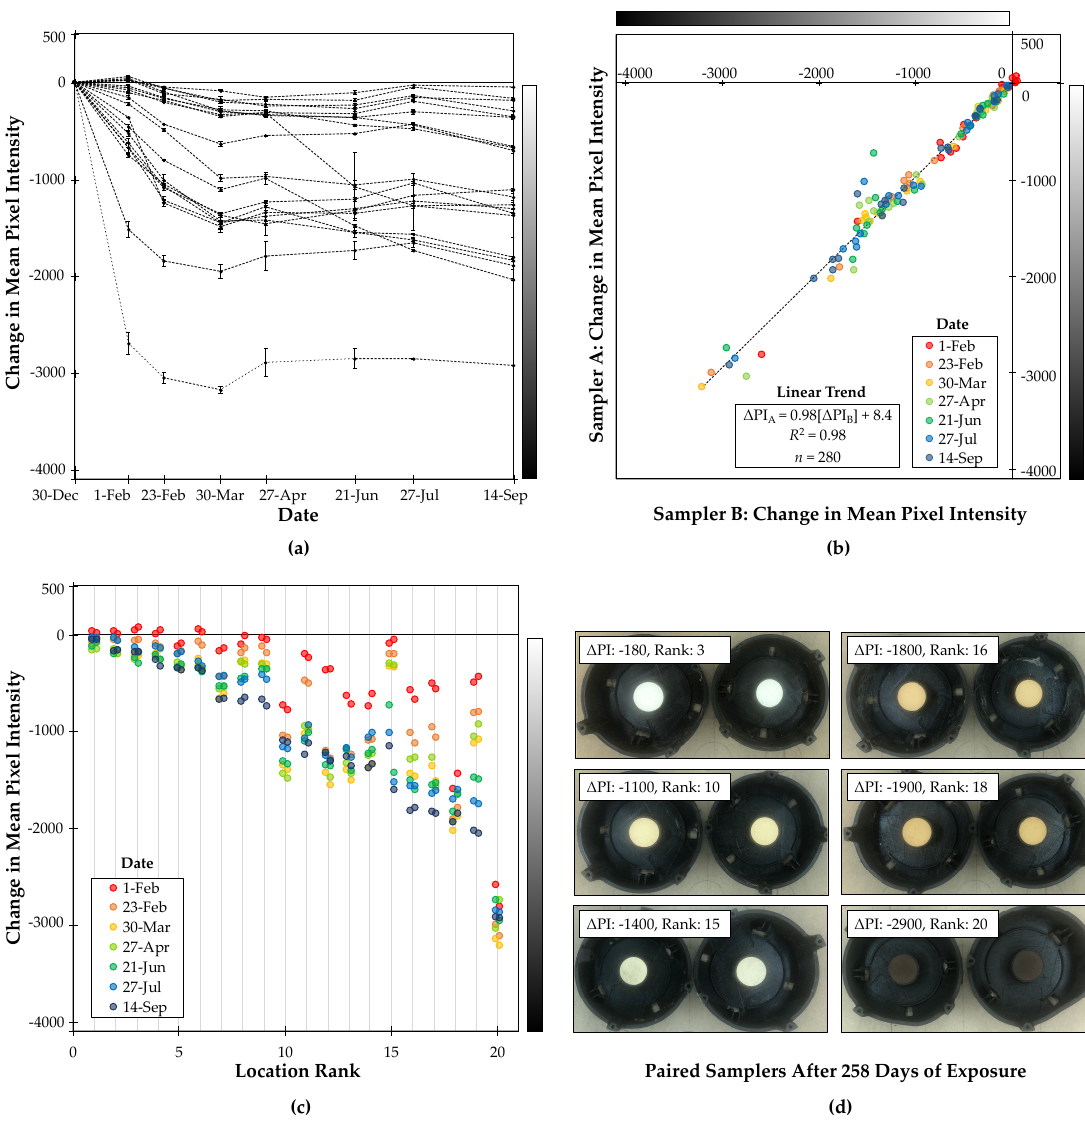
Figure 3. Change in reflectance of paired samplers in 20 indoor locations during 258 days in a community that uses solid fuels. Change in reflectance (measured by change in mean pixel intensity ( ∆ PI; unitless) and illustrated by grayscale) ranges from 0 (indicating no change in grayscale) to − 4095 (indicating a change from perfect white to perfect black). ( a ) Average change in reflectance of samplers at each location ( n = 20) versus time (7 sampling dates). Points represent the average and error bars indicate the range of darkening for the two samplers placed together at each location. Each line represents one location. ( b ) Scatterplot of change in reflectance of samplers placed at the same location (Sampler A vs Sampler B) by sampling date ( n = 280). ( c ) Variability in change in reflectance among locations and within locations by sampling date. Locations are plotted in rank order (smallest to largest change in reflectance, 1 to 20) based on average change in reflectance of the paired samplers on 14 September (day 258 of exposure). Points represent each sampler at each location. ( d ) Paired samplers (after 258 days of exposure) with total change in mean pixel intensity (average of paired samplers) and rank (smallest to largest change in reflectance, 1 to 20) to illustrate range in change of exposure surface reflectance across six